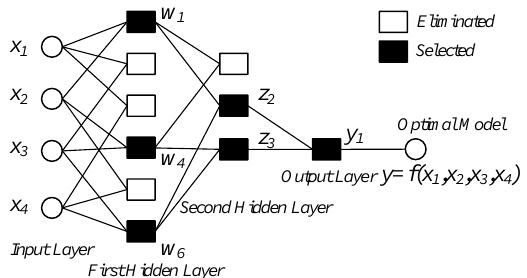
Figure 3. Structure sample of GMDH for surface roughness prediction.